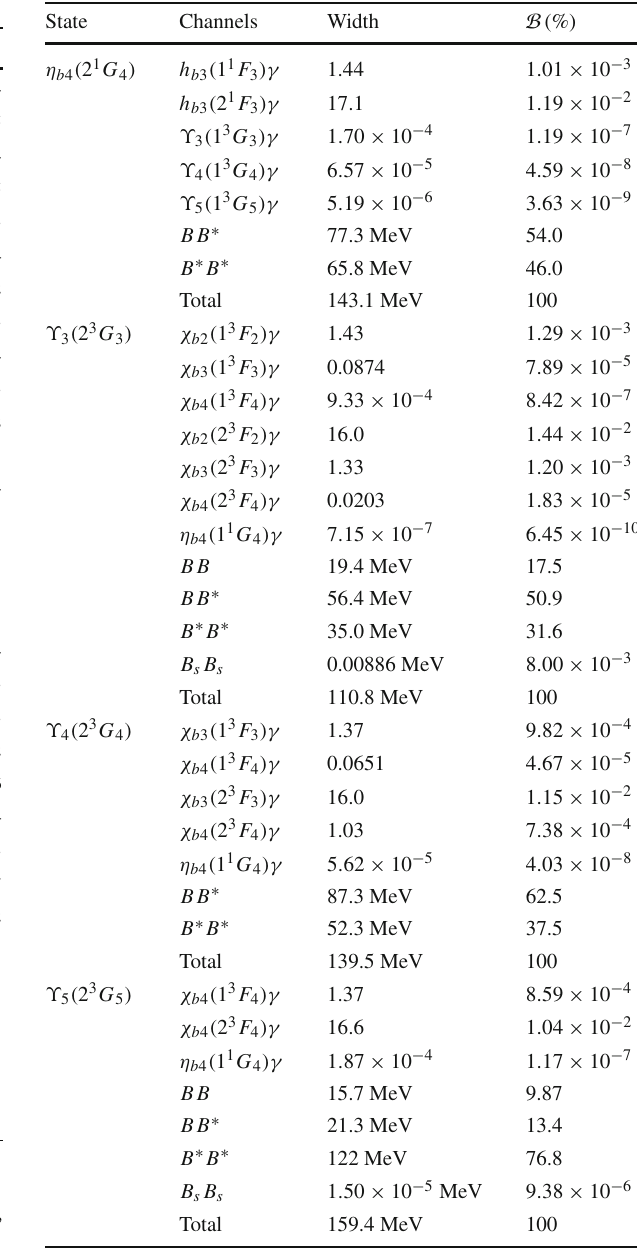
Table38 PartialwidthsandbranchingratiosoftheOZI-allowedstrong decay, and radiative transition and the total widths for the 2 G bottomo- nium states. The width results are in units of